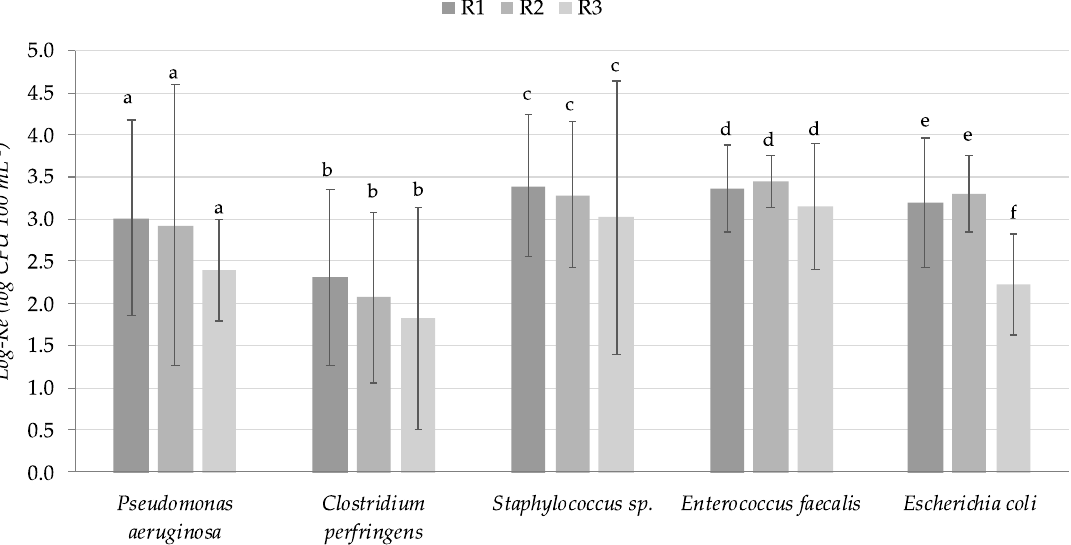
Figure 2. Logarithmic removal of Pseudomonas aeruginosa , Clostridium perfringens , Staphylococcus sp., Enterococcus faecalis , and Escherichia coli in R1, R2, and R3 during the operational stage. Results in average ± standard deviation. Values with the same letter (a, b, c, d, e, and f) are statistically equal ( α = 0.05). The number of replicates performed was n = 20.